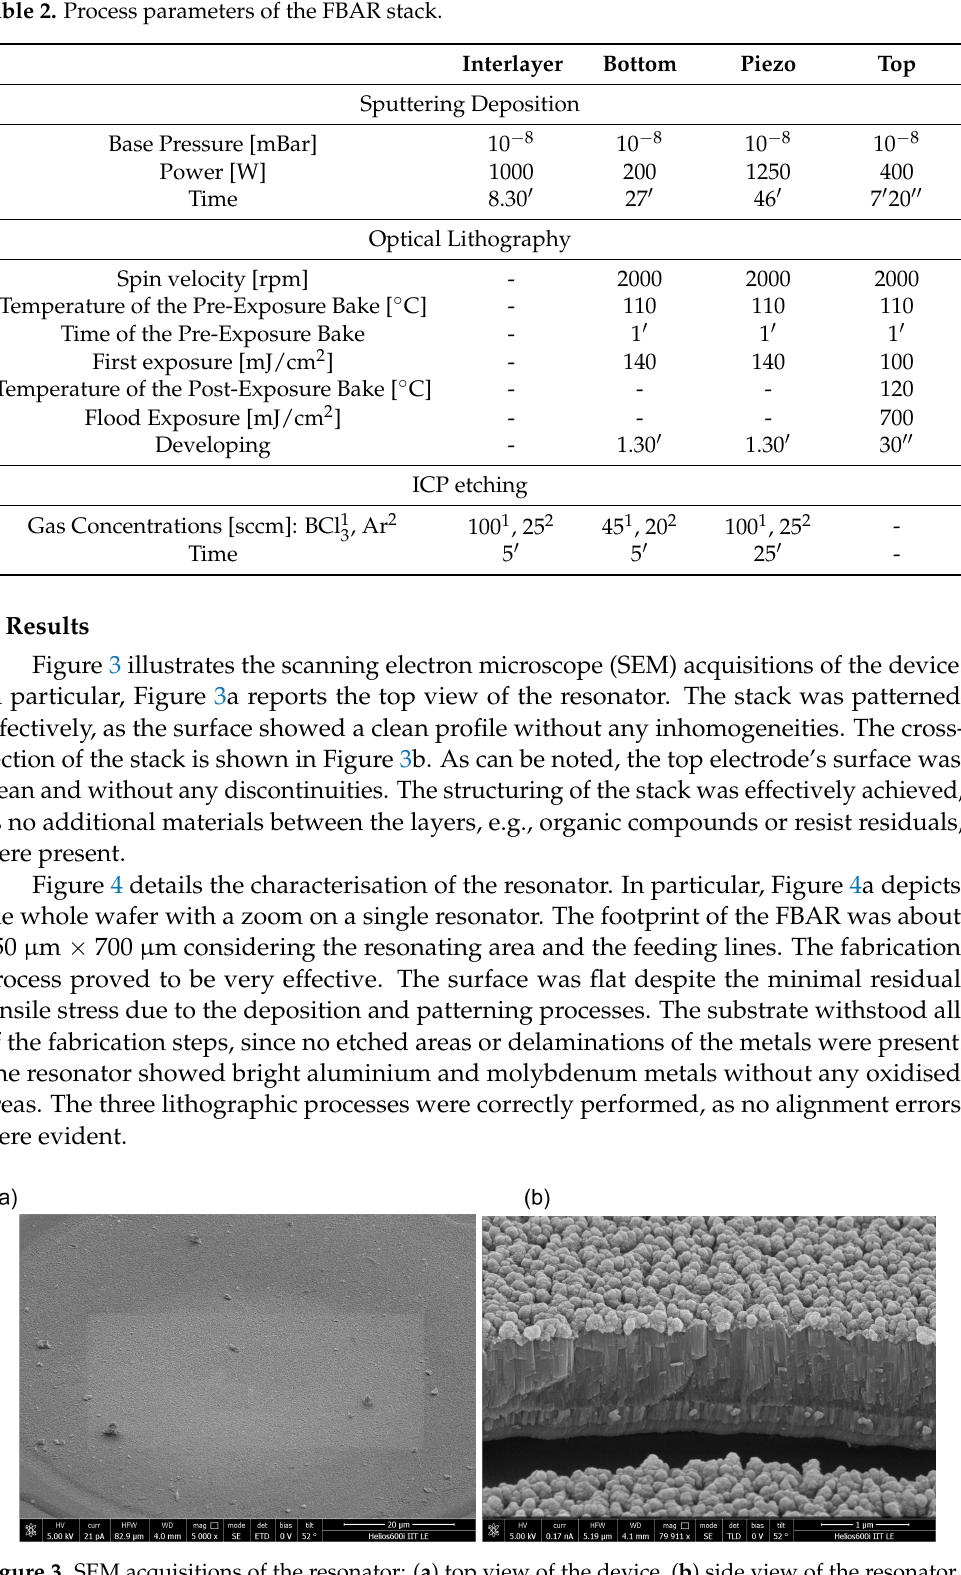
Figure 3. SEM acquisitions of the resonator: ( a ) top view of the device, ( b ) side view of the